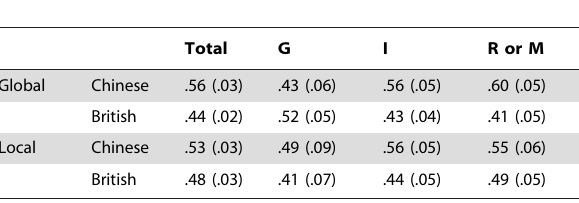
Table 4. Mean Values of A 9 for Each Attribution of Each Group in the Classification Test for Target